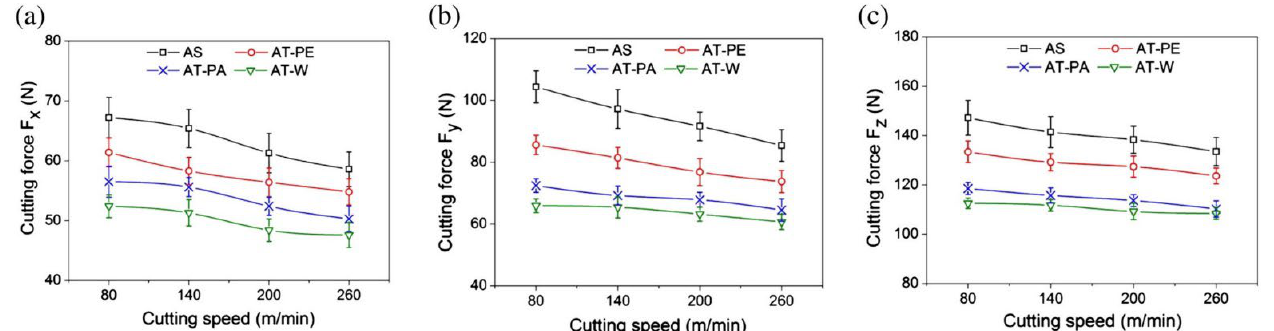
Figure 16. Cutting forces of four kinds of tools at different cutting speeds: ( a ) axial thrust force F x ; ( b ) radial thrust force F y ; and ( c ) main force F z , ( a p = 0.2 mm, f = 0.2 mm/r). AT-PE—linear grooves perpendicular to the cutting edge, AT-PA—linear grooves parallel to the cutting edge, AT-W—and wavy grooves [74].